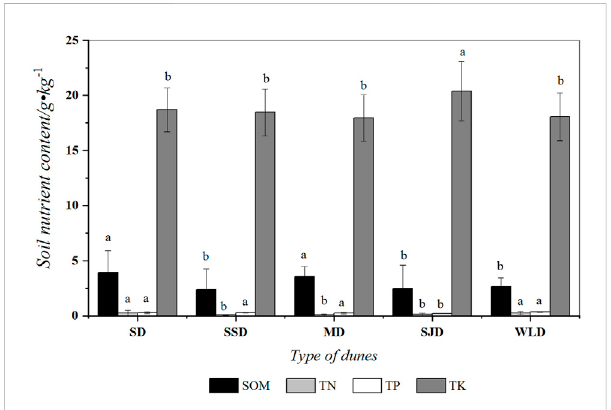
FIGURE 2 Organic matter and nutrient content 80 cm below the surface of deposits in dunes examined. Note: different letters indicate organic matter and nutrient content differed signi fi cantly between communities ( p < 0.05); the same letter indicates no signi fi cant difference ( p > 0.05).